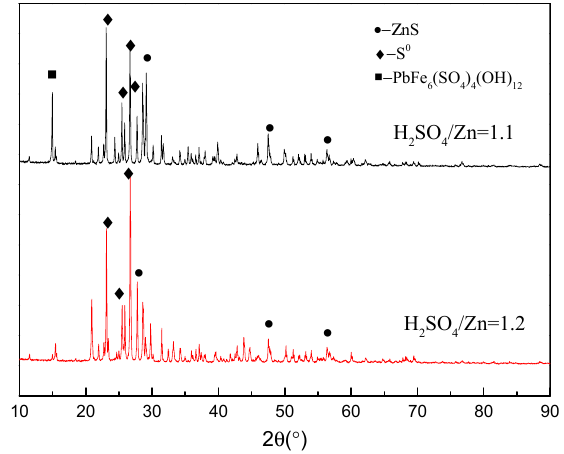
Figure 8. XRD patterns of residues with different acidities.